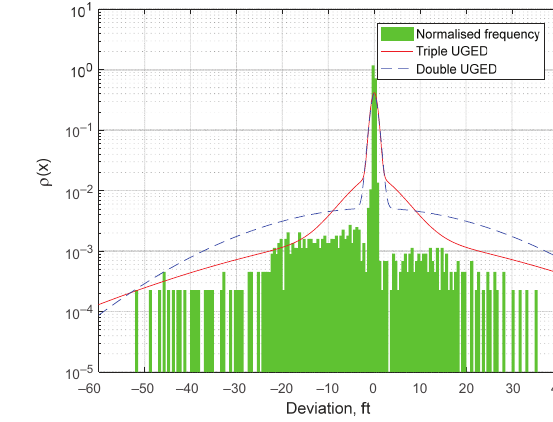
Figure 3. Lateral deviation statistics Figure 6. TUGED for the whole statistic Table 4. Performance of approximation and results of risk assessment